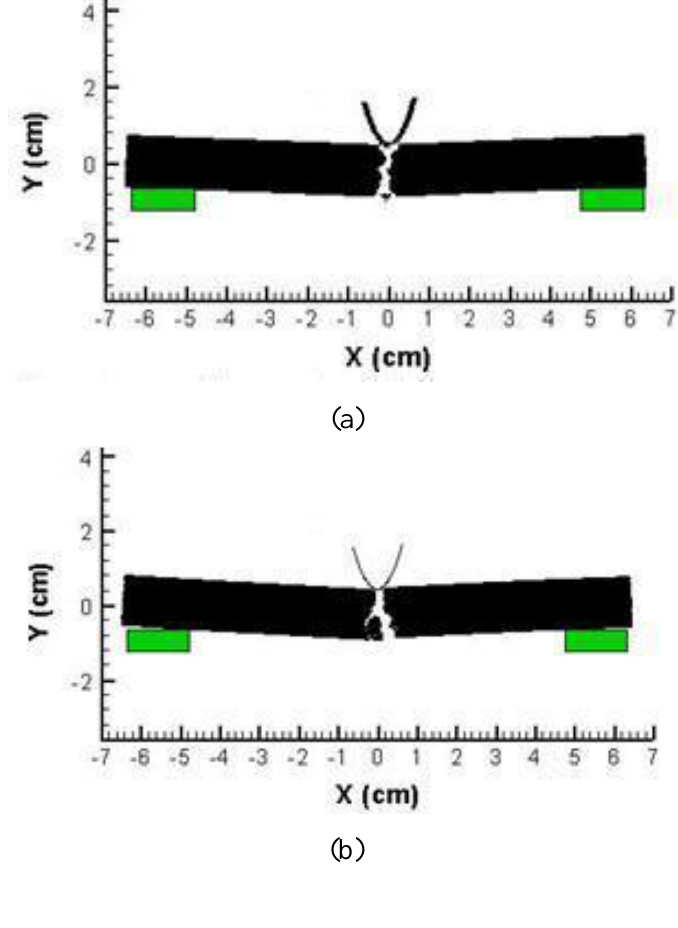
Figure 4. Fracture prediction of materials with varying Poisson's ratios using